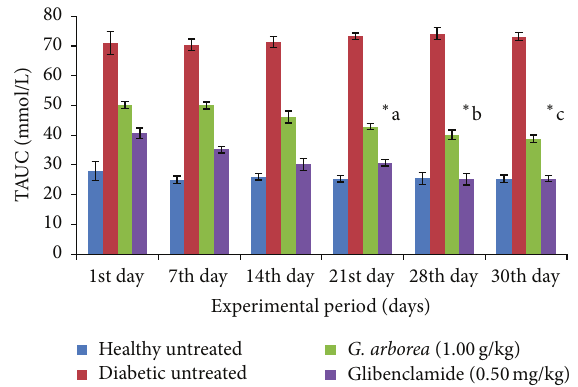
Figure 2: Effect of aqueous bark extract of Gmelina arborea (1.00 g/kg) on total area under the curve (TAUC) values in strep- tozotocin induced diabetic rats for 30 days. Data are expressed as mean ± SEM ( 𝑛 = 6 /group). From the 21st day onwards, total area under the curve value of G. arborea (1.00g/kg) treated rats is significantly different from the total area under the curve values of diabetic untreated rats ( ∗ a, b,